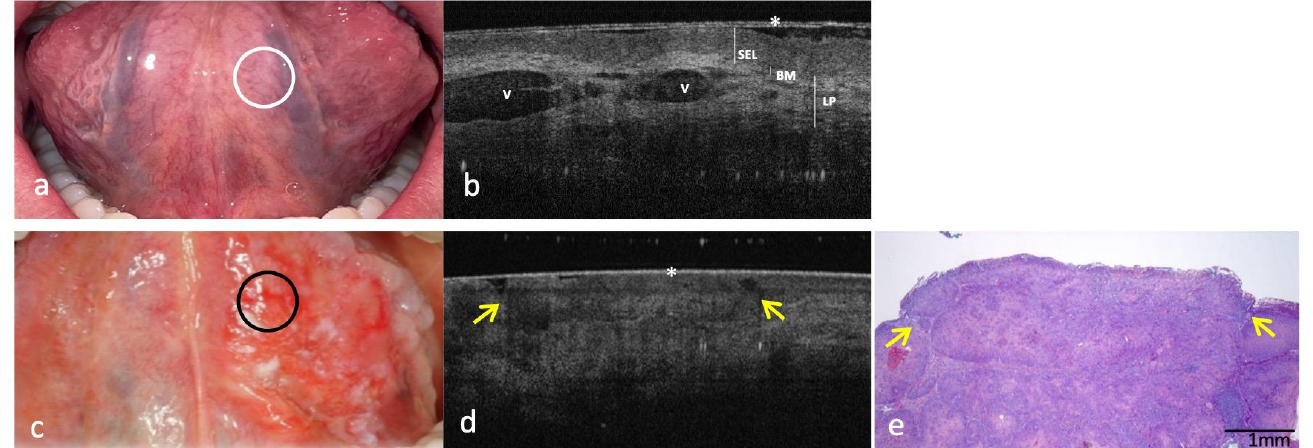
Figure 3. Clinical, OCT and histopathology images of a case of OSCC on the ventral surface of the tongue compared with the same healthy site (code C02.2). ( a , b ): Clinical and OCT images of healthy mucosa of the ventral surface of the tongue; the site of in vivo OCT evaluation is indicated with a white circle. ( c – e ): Clinical, OCT and histopathological images of (H-E stain; original magnification ×25) confirmed OSCC on the ventral surface of tongue; the site of in vivo OCT evaluation is indicated with a black circle. An asterisk (*) indicates the thin transparent plastic wrapping around the scan- ning probe; superficial ulcerations are indicated by a yellow arrow. SEL — Stratified Epithelial Layer; BM — Basement Membrane; LP — Lamina Propria; V – vascular structures of sublingual area.